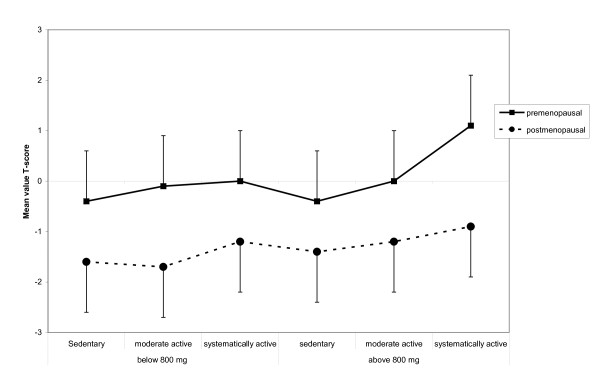
Synergy between physical activity and dietary calcium intake in women consuming calcium amounts greater than 800 mg/day. This graphic depicts mean QUS T-score values calculated according to daily calcium intake in all premenopausal and postmenopausal activity groups using 800 mg daily as cut off point (for statistical significant values see text).